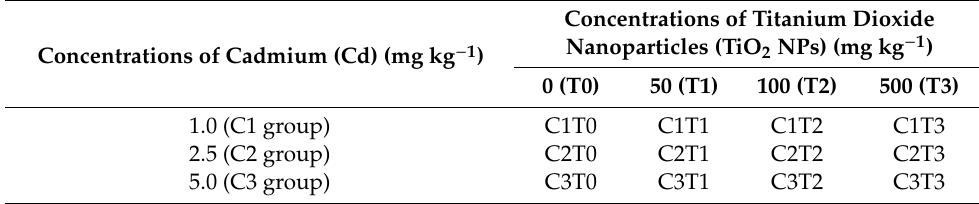
Table 1. Experimental